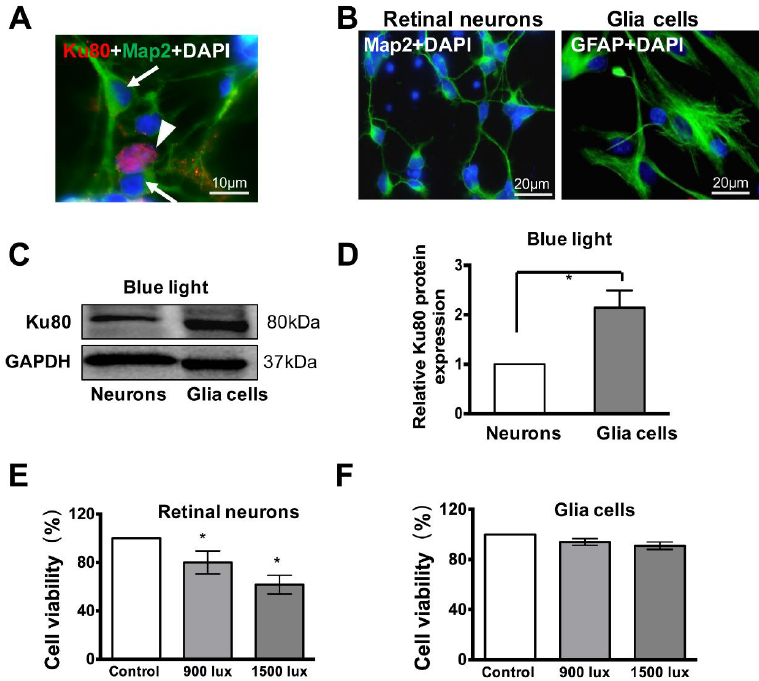
Figure 5. Ku80 is more up-regulated in glia cells than that in neurons. ( A ) Ku80 is more up-regulated in retinal glia cells other than retinal neurons. ( B ) The retinal neurons and glia cells are labelled with Map2 and GFAP, respectively. ( C ) Western blot assay demonstrates that Ku80 is more up-regulated in glia cells than that in neurons upon blue light treatment. ( D ) The relative protein expression of Ku80 in glia cells and neurons were presented as a histogram. ( E ) The blue light impairs the cell viability of retinal neurons. ( F ) The blue light does not affect the cell viability of glia cells. Error bars represent mean ± SD. Asterisks indicate statistically significant differences between control and experimental samples (* p <